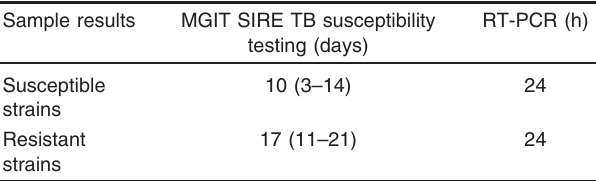
Table 2 Mean time required for drug susceptibility testing of Mycobacterium tuberculosis Sample results